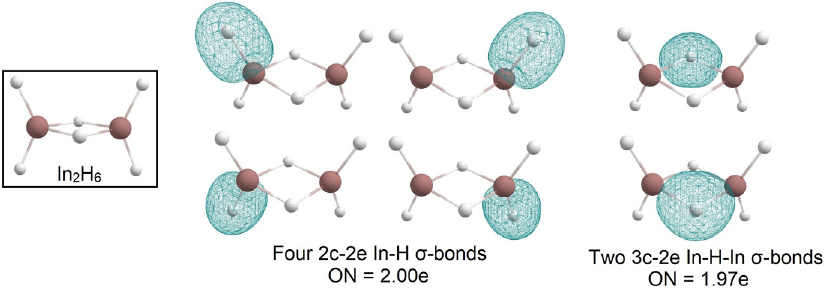
Figure 7. The chemical bonding pattern of the In 2 H 6 global minimum structure obtained by AdNDP analysis.